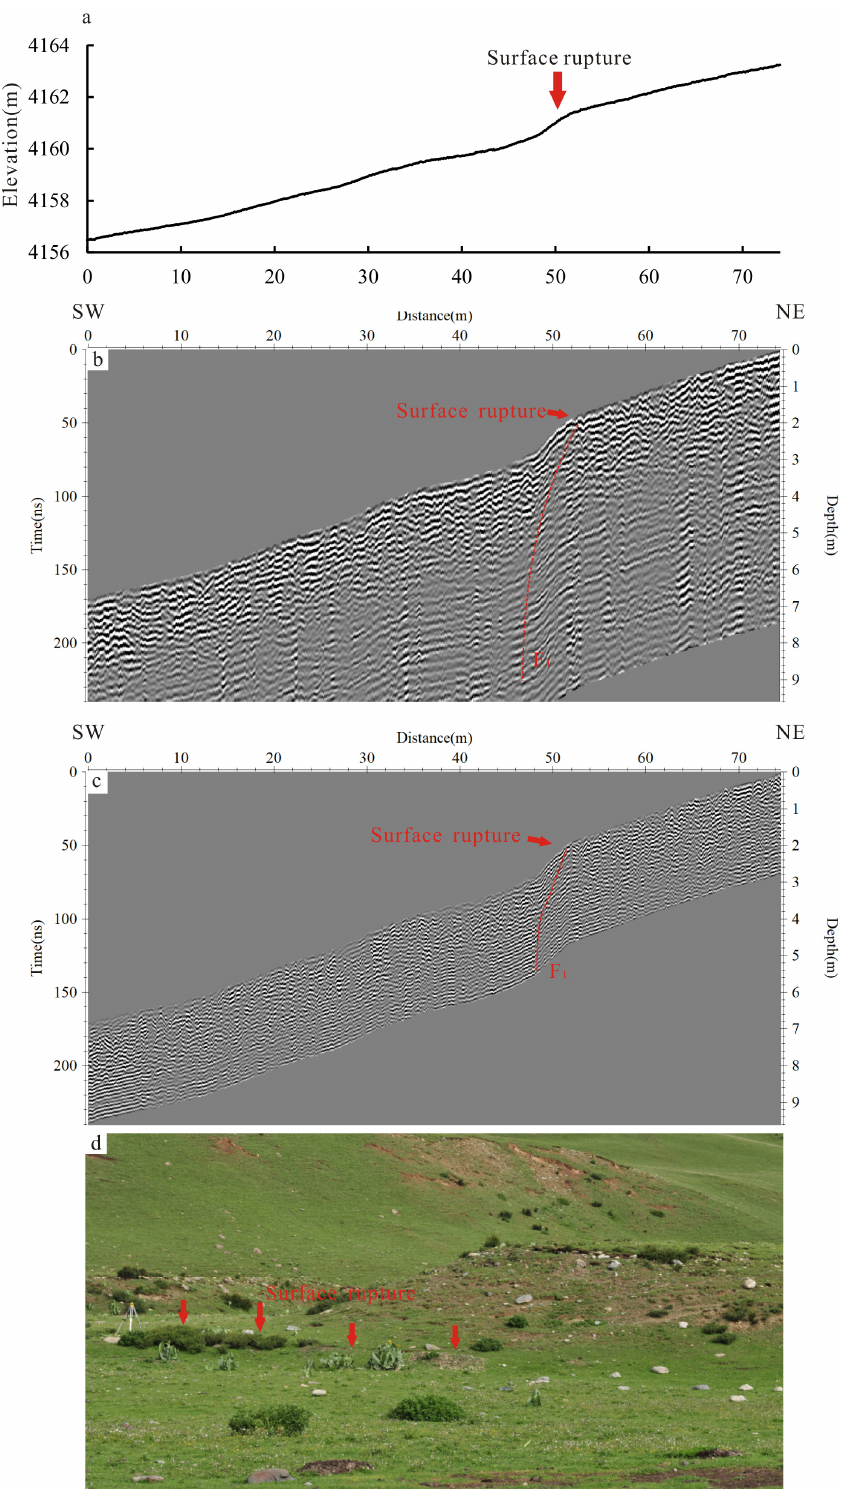
Figure 9. The 250 MHz and 500 MHz GPR interpreted images. ( a ) show the topographic data of the GPR survey line 1. ( b , c ) show the processed 250 MHz and 500 MHz GPR profiles with SW-NE trending in the survey line 1. ( d ) show the surface ruptures on the GPR survey line